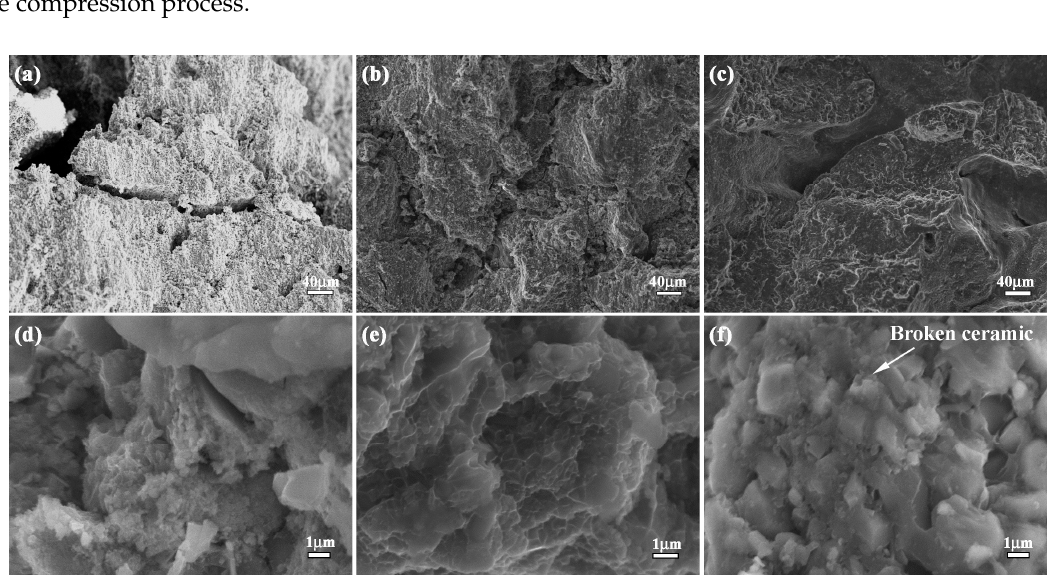
Figure 9. Compression appearance of bionic layered composite ( a ) outer layer ( b ) middle layer ( c ) inner layer ( d ) magnified microstructure of ( a ); ( e ) magnified microstructure of ( b ); and ( f ) magnified microstructure of ( c ).